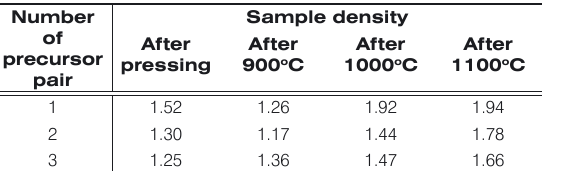
Table 2. Sample density (g cm -3 ) after pressing (100 MPa) and sintering at 900 o C, 1000 o C, 1100 o C.